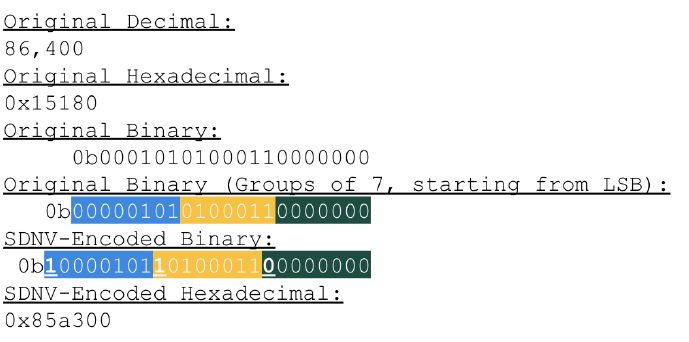
Figure 2. Example SDNV encoding where the blue, yellow, and green highlights a group of 7 bits that is modified to become an octet of bits. The Most Significant Bit (bolded and underlined) in the first two octets are a 1 indicating that this is not the last octet within this piece of